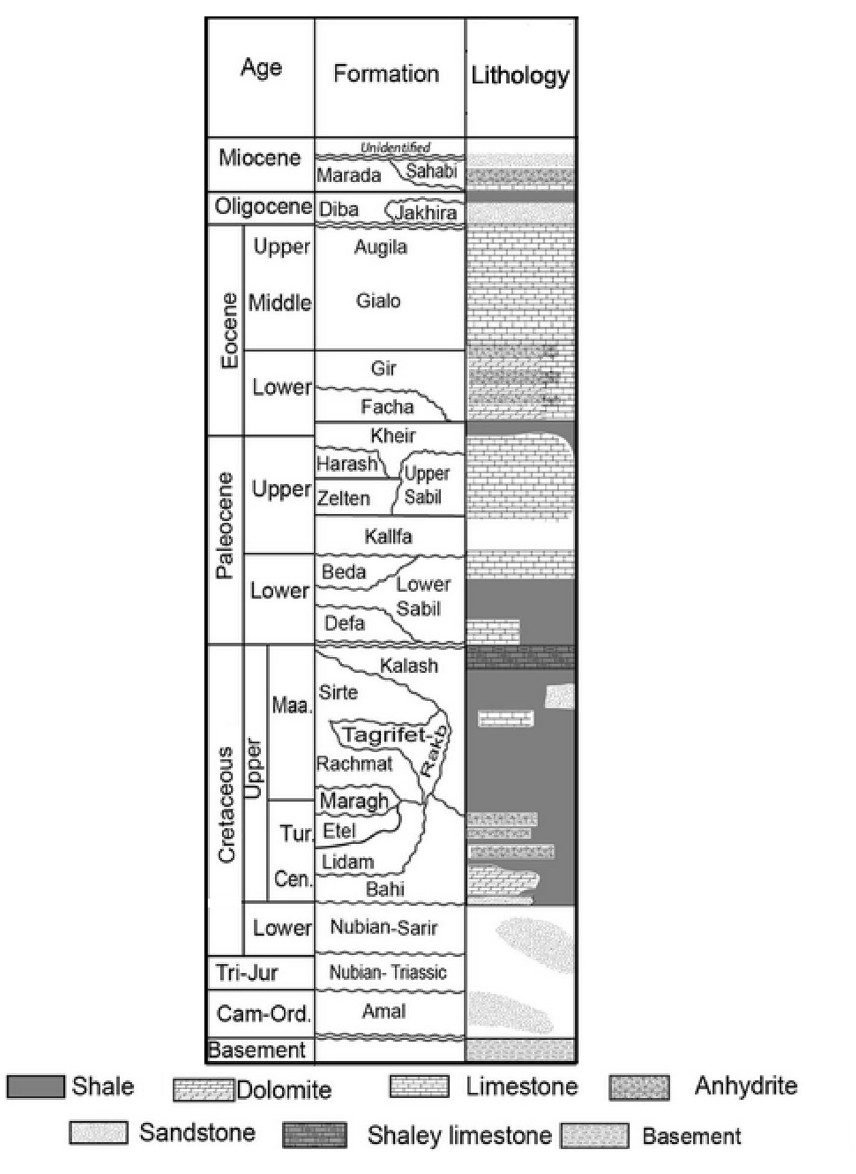
Fig. 3 General stratigraphic column of Sirte basin. Modified after Aboglila and